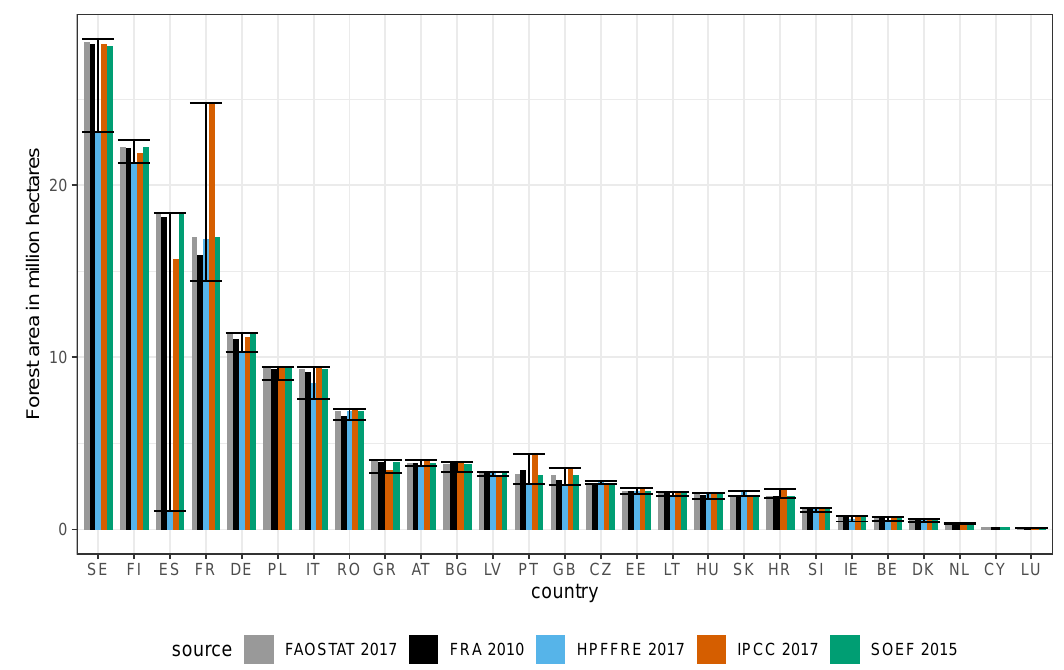
Figure A3. Forest area for the most recent year available in each dataset and each country. For each country, the error bars represent the minimum and maximum values over all time series and all